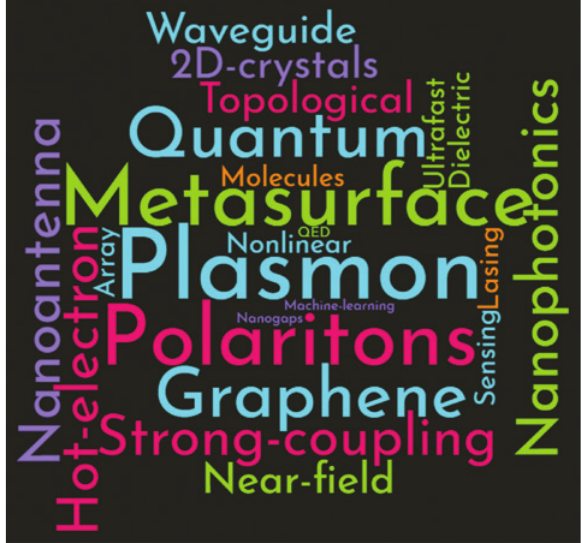
Figure 1: The breadth of research topics and directions within plasmonics illustrated by a word cloud compiled from the book of